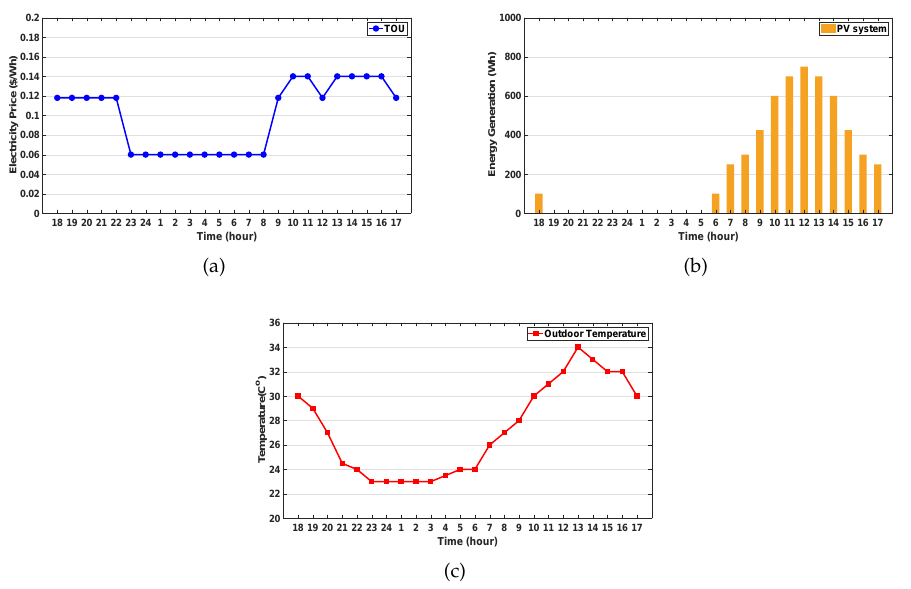
Figure 3. Profiles of electricity price and weather. ( a ) time-of-use (TOU) price; ( b ) photovoltaic (PV) generation; ( c ) outdoor